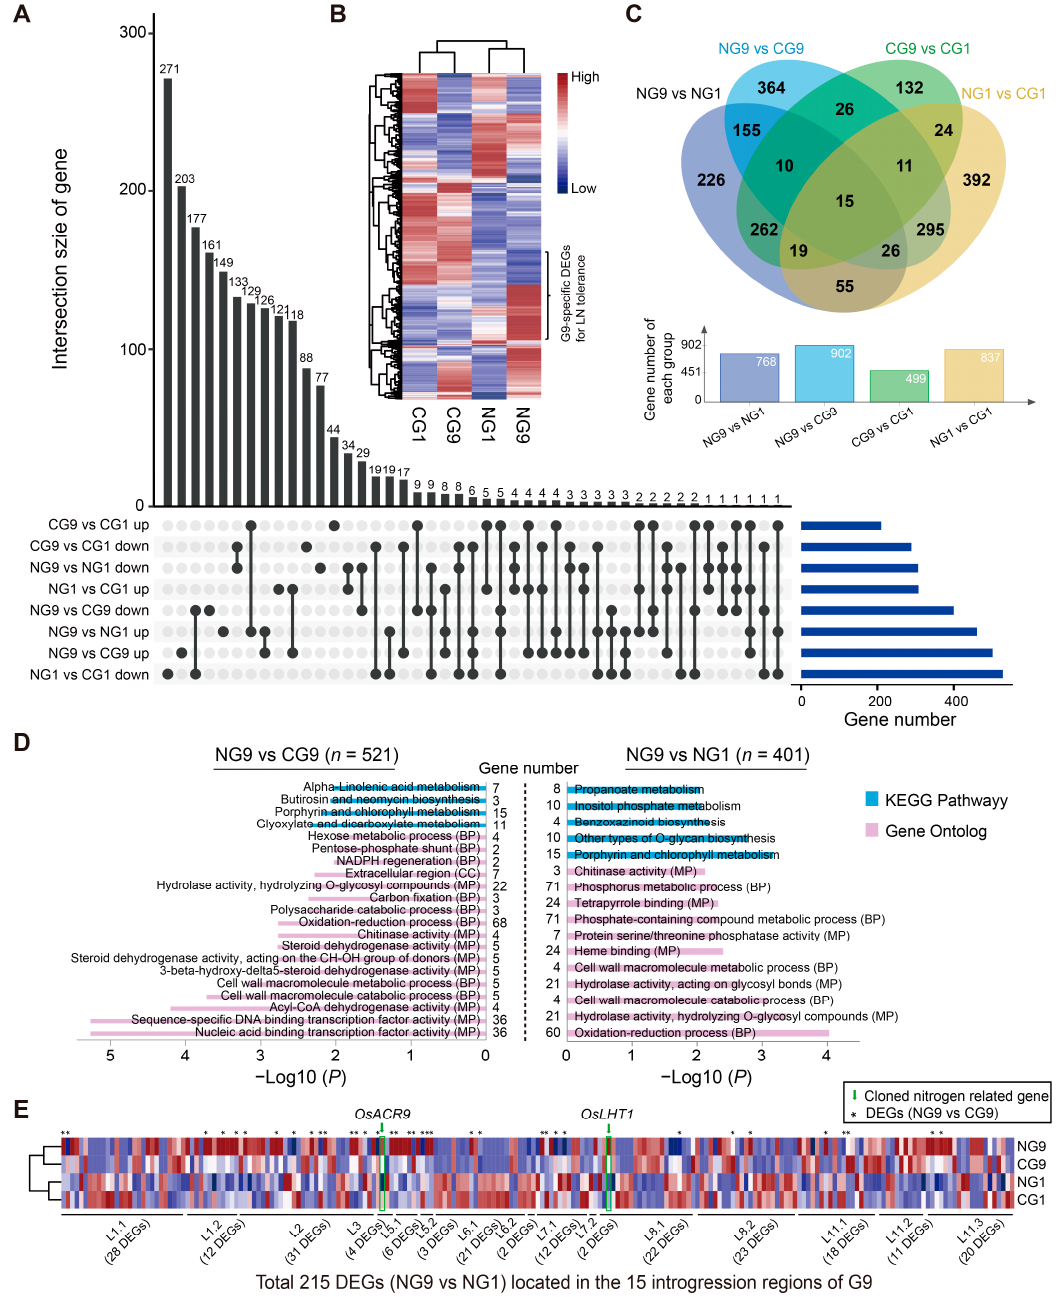
Figure 2. Transcriptome analysis of differentially expressed genes (DEGs) of G9 and G1 under low nitrogen and control conditions. ( A ) Intersection of DEGs between genotypes and between treatments. ( B ) Gene expression patterns of DEGs. ( C ) Venn diagram of all DEGs between G9 and G1. ( D ) GO and KEGG enrichment analysis of NG9-vs-CG9 DEGs and NG9-vs-NG1 DEGs. ( E ) Heatmap for 215 NG9-vs-NG1 DEGs located in the 15 introgression chromosomal regions of G9. Each row represents a sample and each column represents a DEG located in an introgressed segment in the heatmap. The asterisks and green arrows above the heat map represent the NG9 ‐ vs ‐ CG9 DEGs and cloned nitrogen related genes, respectively.